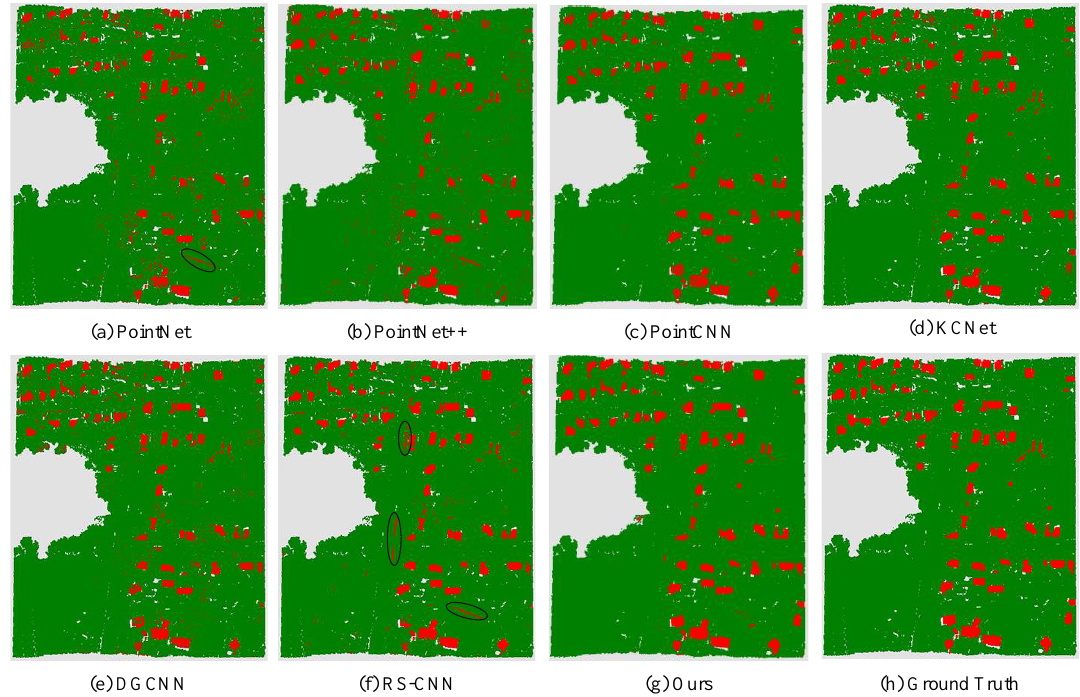
Figure 9. The visualization of overall extraction comparison results. The green colored points are the